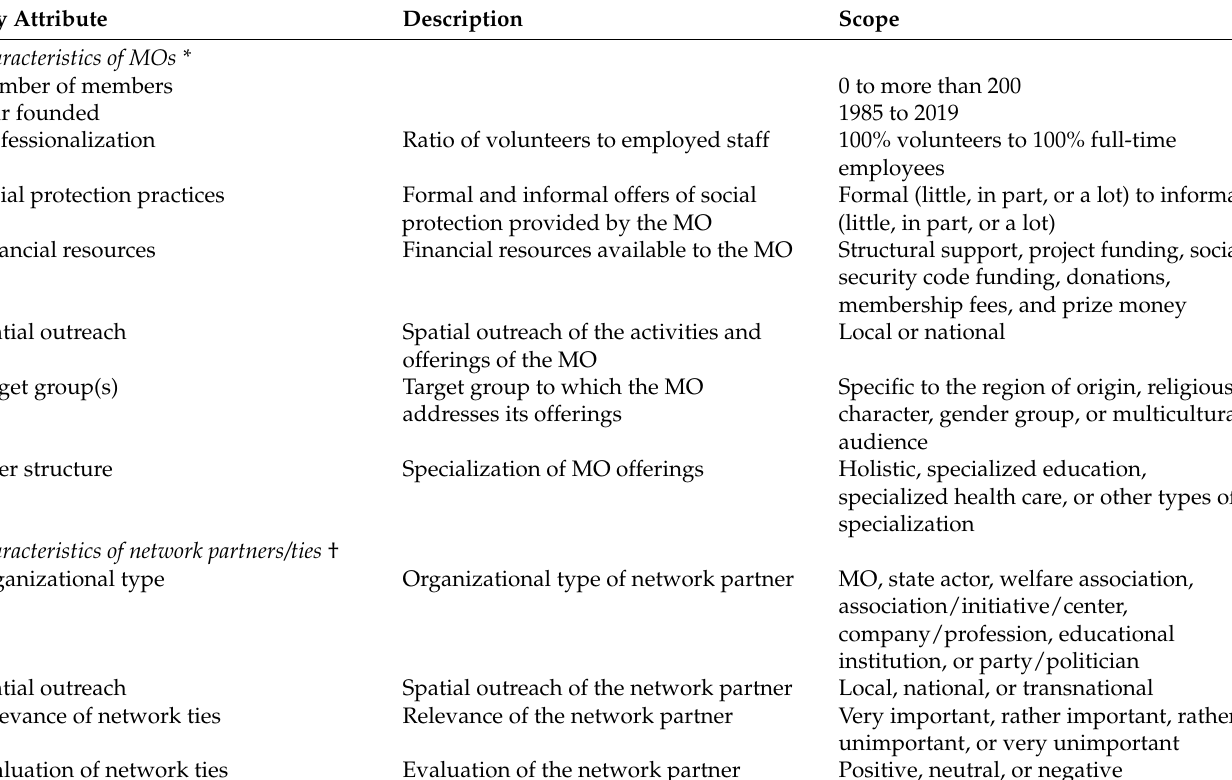
Table 1. Key attributes of